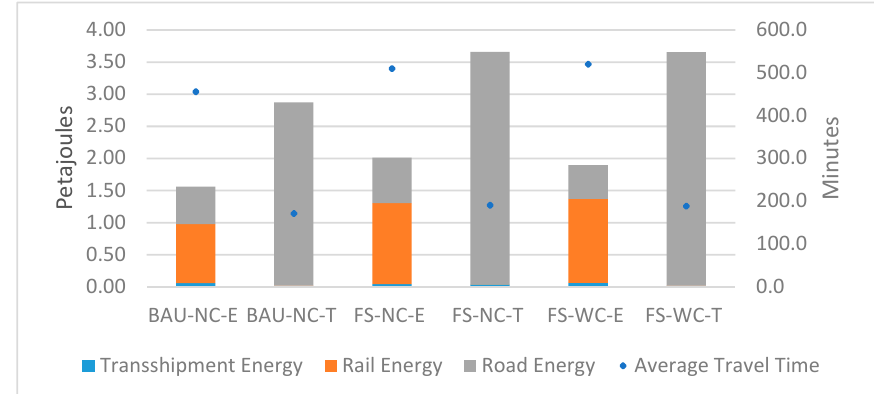
Figure 5. Energy demand and average trip time for different scenarios.